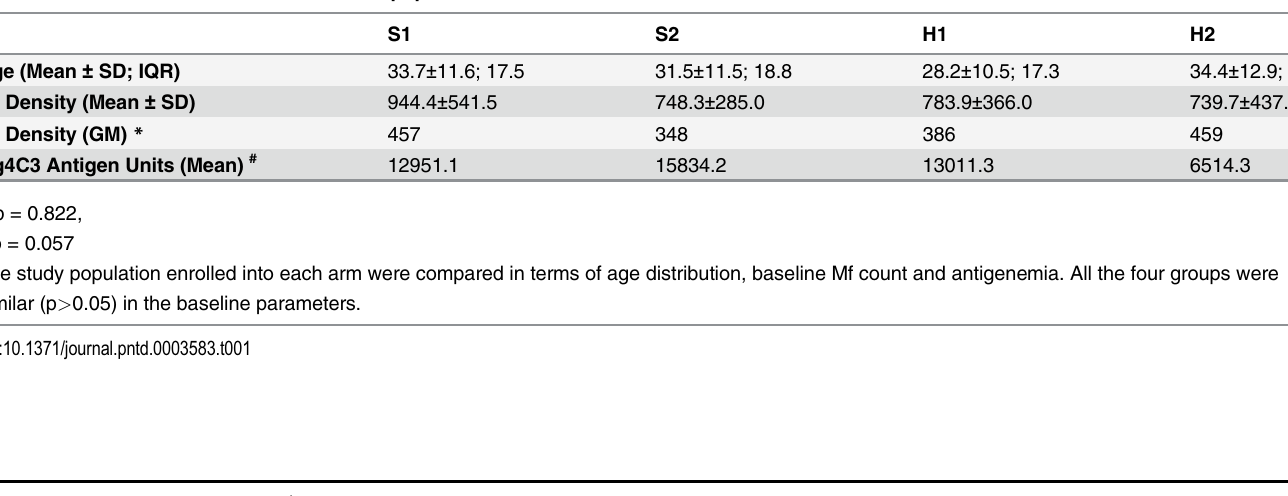
Table 1. Baseline characteristics of the four populations in different treatment arms.